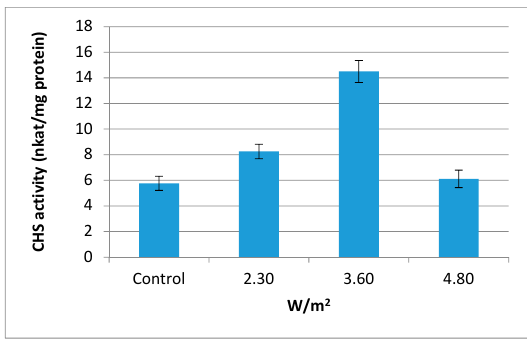
Figure 1. Effect of UV-B irradiation (3.60 W/m 2 , 8-h) on CHS enzyme activity in sweet basil